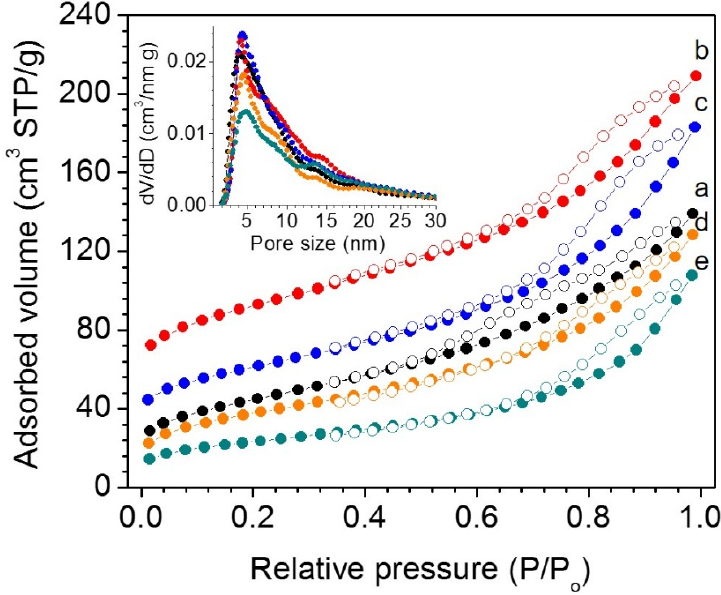
Figure 3. Nitrogen adsorption–desorption isotherms at 77 K and the corresponding nonlocal density functional theory (NLDFT) pore-size distribution plots calculated from the adsorption branch (inset) for mesoporous ( a ) mp -CeO 2 ; ( b ) CuO(16)/CeO 2 ; ( c ) CuO(26)/CeO 2 ; ( d ) CuO(38)/CeO 2 and ( e ) CuO(45)/CeO 2 materials (STP: standard temperature and pressure). For clarity, the isotherms of ( a ), ( b ) and ( c ) are offset by 5, 40 and 20 cm 3 ·g − 1 ,